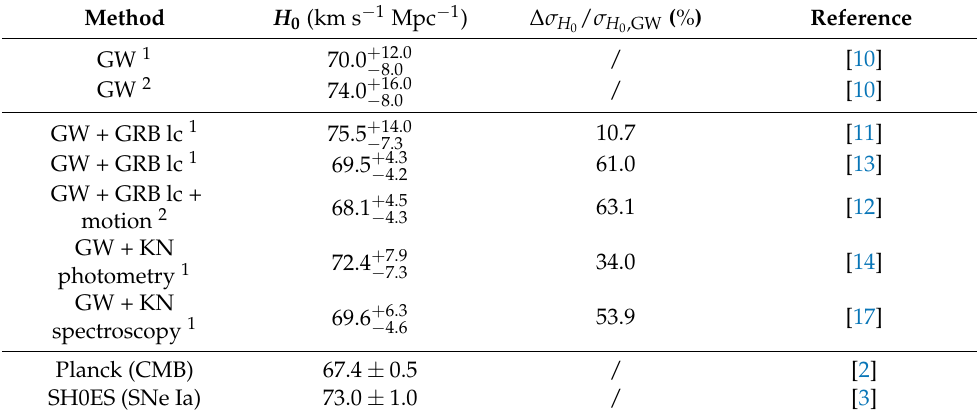
Table 1. H 0 values obtained for GW170817 with the standard siren approach (’GW’), together with improvements using inclination constraints from model fitting of the different EM probes: the associated GRB afterglow light curve with (’GW + GRB lc + motion’) or without (’GW + GRB lc’) constraints on from the jet superluminal motion; and the KN broad-band photometry (’GW + KN photometry’) and spectroscopy (’GW + KN spectroscopy’). The ∆ σ H ) / σ σ H H 0 ,GW column shows the percentage improvement in the 68.3% (1 σ ) interval. H 0 values 0 derived from CMB and are shown for